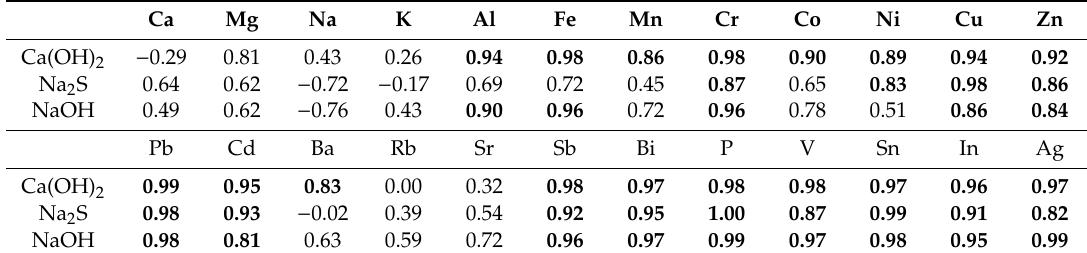
Table 9. Values of correlation coe ffi cients between As and elements in solution during the experiments with Ca(OH) 2 , Na 2 S and NaOH. Bold indicates values above which the correlation is statistically significant, with a probability of